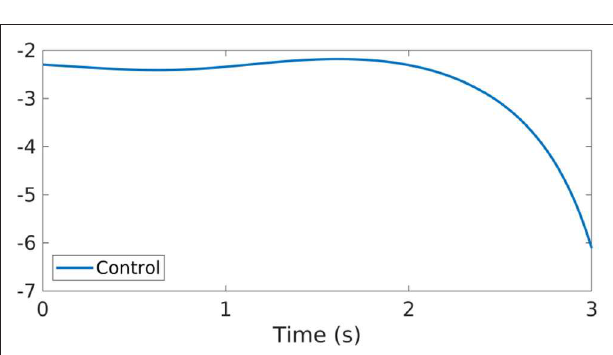
u obtained through the GD-RBM algorithm b